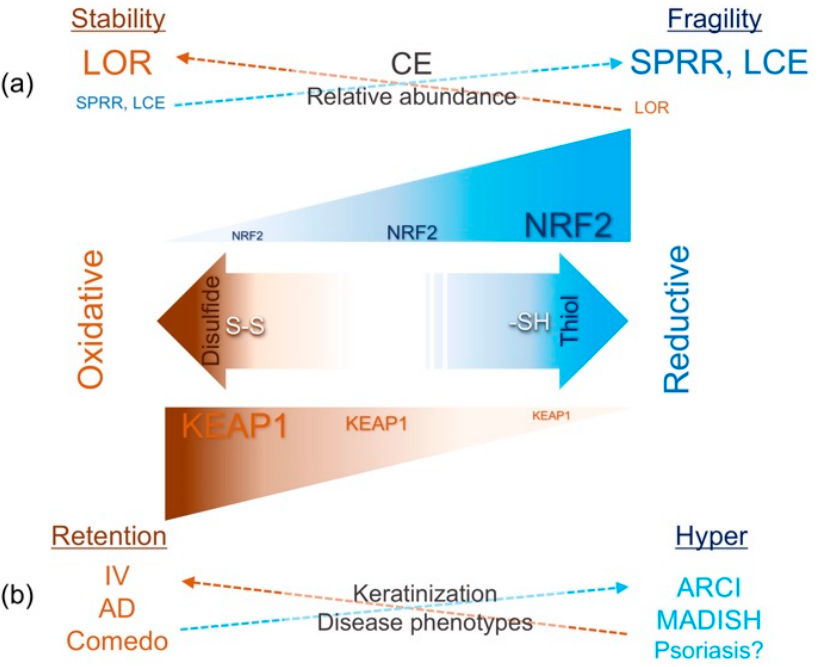
Figure 6. The KEAP1 / NRF2 signaling pathway in keratinization and related skin diseases. ( a ) Phenotypes of the cornified cell envelope (CE). The oxidized status preferentially stabilizes the CE, and loricrin (LOR) promotes cytoskeletal cross-linkage. NRF2 repairs a defective barrier, probably in response to a perturbed redox balance, whereas persistent NRF2 activation hampers the formation of disulfide cross-linkage and makes the CE fragile. ( b ) Keratinization and disease phenotypes. An oxidative environment favors retention keratosis, which can lead to common dry skin conditions such as atopic dermatitis (AD) (clinically non-inflamed skin), or comedo (occluded hair follicle due to infundibular keratinization). On the other hand, strong and persistent NRF2 activation may be associated with autosomal recessive congenital ichthyosis (ARCI) or metabolizing acquired dioxin-induced skin hamartomas (MADISH).